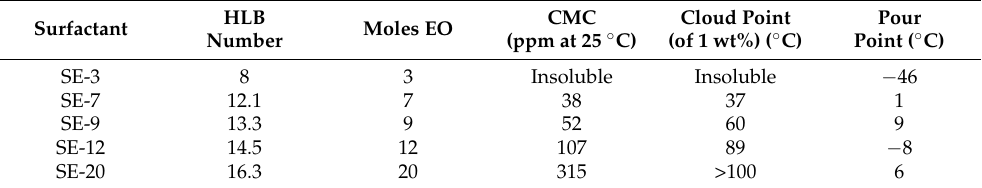
Table 1. Physical properties of the studied secondary alcohol ethoxylate nonionic